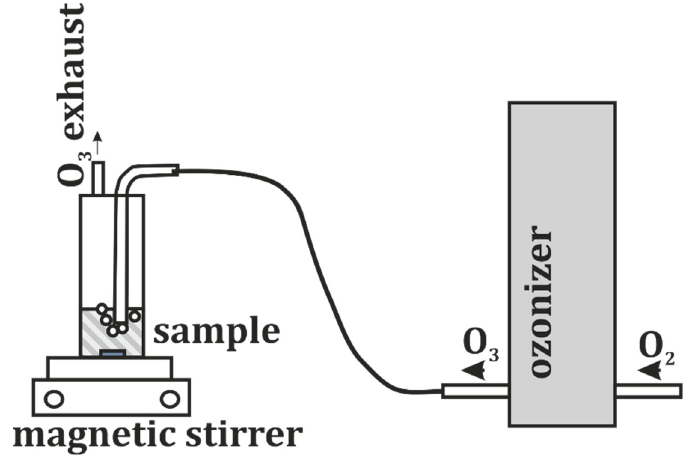
Figure 1. Schematic of the ozone treatment setup. On the right side is an ozonizer, with gas in- and outlet. The outlet is connected to a washing flask containing the sample, which is mounted on a magnetic stirrer.